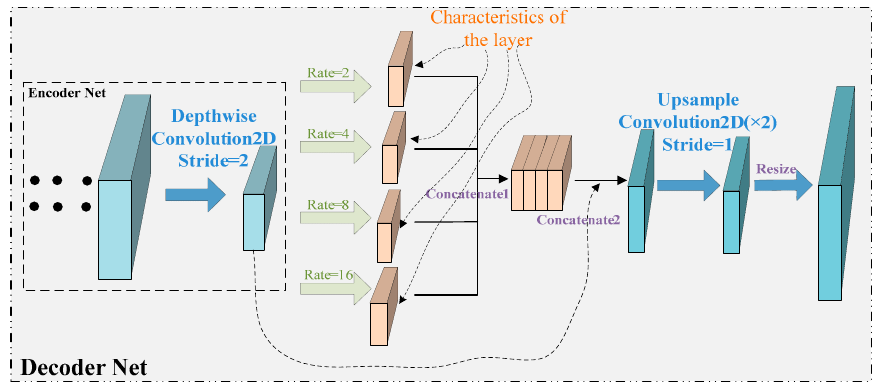
Figure 6. The decoding network structure. Combined with the adopted encoding network and decoding network, the whole network model framework is constructed, as shown in Figure 7 and the algorithm block diagram is shown in Figure